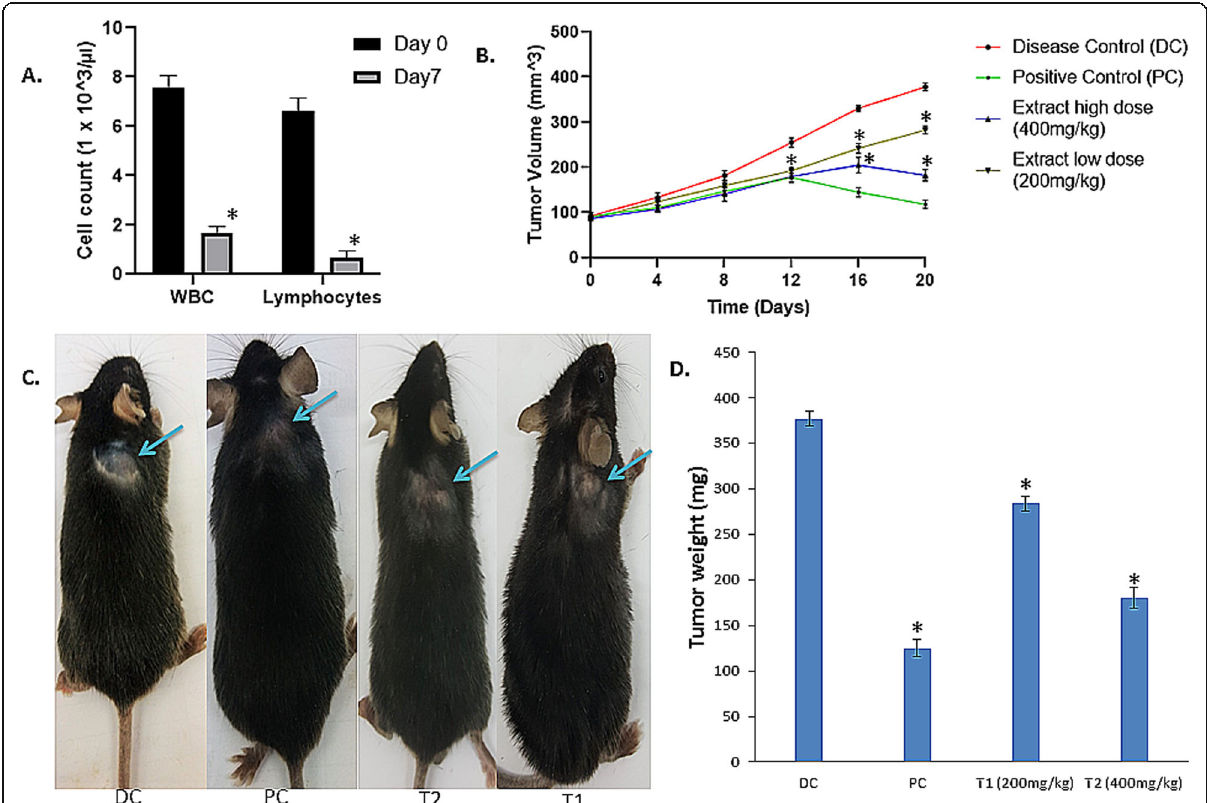
Fig. 5 In vivo antitumor activity of MEUP tested at two dose levels (200 mg/kg and 400 mg/kg). a Immunosuppression: difference in WBC and lymphocyte counts of C57bl/6 mice on day 0 and day 7. Results are represented as mean ±SD ( n = 24). * represents significant differences in cell counts on day 0 and day 7 in immunosuppressed mice. b Reduction in tumor volume of mice in different groups. Significant reduction in tumor volumes was observed in positive (cisplatin) and test groups (T1 and T2). Results are represented as mean ± SD. The asterisk represents a significant difference in tumor volume between DC and treatment groups. c Representative images of tumor bearing mice treated with cisplatin and MEUP. Tumor position in mice is shown by arrows. d Tumor weights of mice treated with cisplatin and MEUP taken at the end of study. Results are represented as mean ± SD. The asterisk represents significant difference in tumor weights between DC and treatment groups. ( P < 0.05)